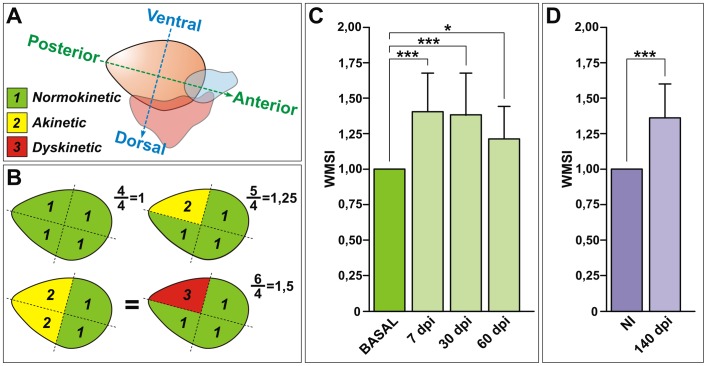
Ventricular wall motion is not fully recovered after cryoinjury.
(A) Schematic representation of segmental criteria of the zebrafish ventricle, considering the antero-posterior and dorso-ventral axis. Depending on their motility, segments are scored as normokinetic (“1”), akinetic (“2”) or dyskinetic (“3”). (B) Theoretical representations of the wall motion score index (WMSI) showing ventricles from healthy controls (WMSI = 1) and cryoinjured animals (WMSI>1). (C) Temporal evolution of changes in the WMSI in cryoinjured animals in a longitudinal study. After injury, the WMSI increased and remained elevated even at 60 dpi, indicating that wall motion is affected. Graphs represent mean values and SD (*** p<0.001; * p<0.05; one-way ANOVA followed by Tukey's honest significant difference test, n = 20). (D) The WMSI is not recovered at extended stages of regeneration (n = 17), and it is not affected in siblings (NI) of the same age (n = 3). *** p = 0.00009, Wilcoxon Signed Rank Test comparing to a theoretical mean of 1. dpi, days postinjury; NI, not injured; WMSI, wall motion score index.